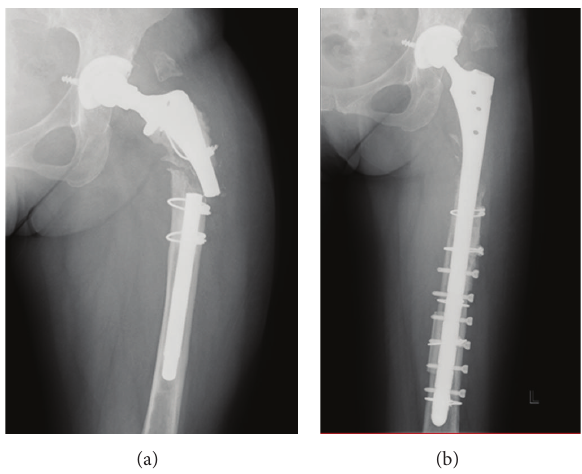
Figure 2: (a) During walking with a single axillary crutch, the stem was suddenly fractured at the site of well-fixated proximal level. (b) Re-revisional THA was performed with Delta-lock system (stem, titanium-6 aluminum-4 vanadium alloy; head, 26-mm Cobalt-chrome- molybdenum alloy (Nakashima Medical Co. Ltd., Okayama, Japan)); cup was not changed.